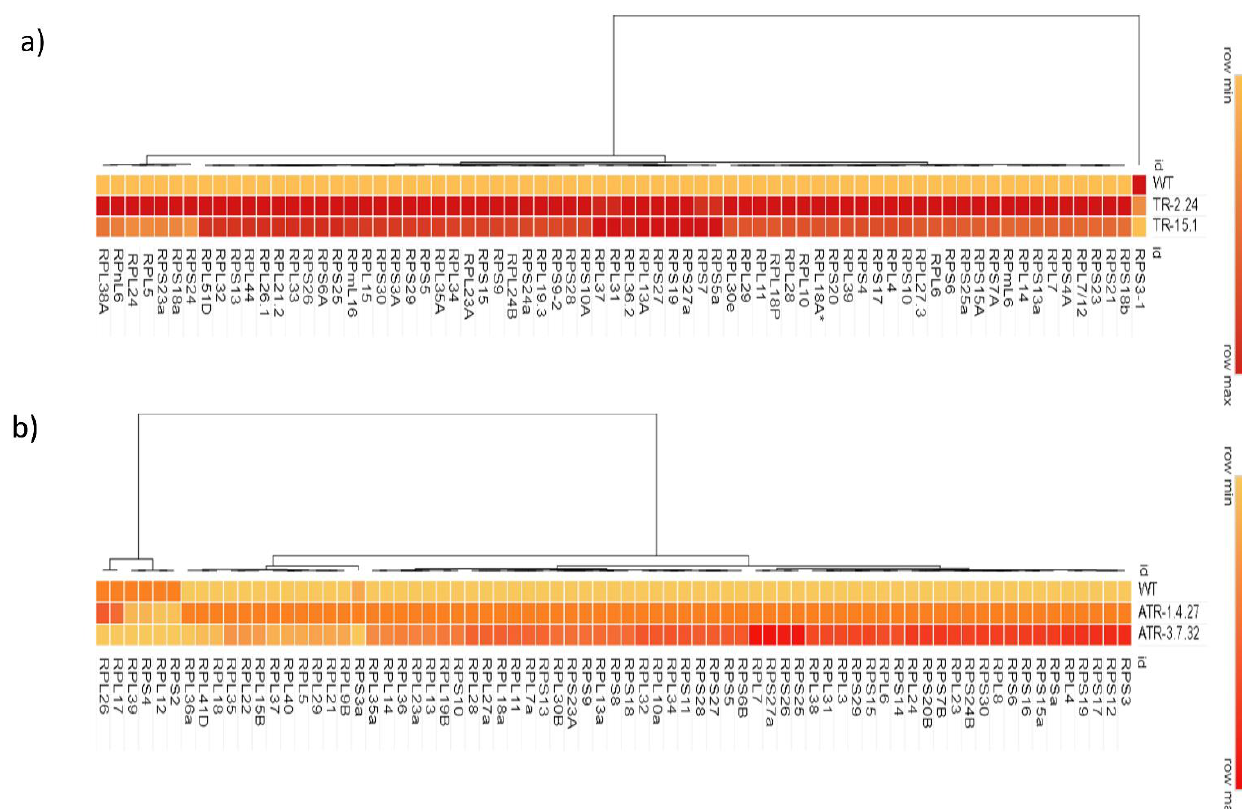
Figure 1. Heatmap representation of expression of RP genes in the TOR -OE lines. Heatmap represents hierarchical clustering of the expression of RPL and RPS genes in TOR -overexpressing lines of rice and Arabidopsis. The RT-qPCR is used to determine the expression levels of ( a ) RPL and RPS genes in the TOR -OE lines TR-2.24 and TR-15.1 of rice and ( b ) in the lines ATR-1.4.27 and ATR-3.7.32 of Arabidopsis. Red and orange colors indicate increased RP gene expression, and the yellow color indicates decreased RP gene expression. The fold change was normalized using the 2 − ∆∆ CT method relative to their corresponding WT control.